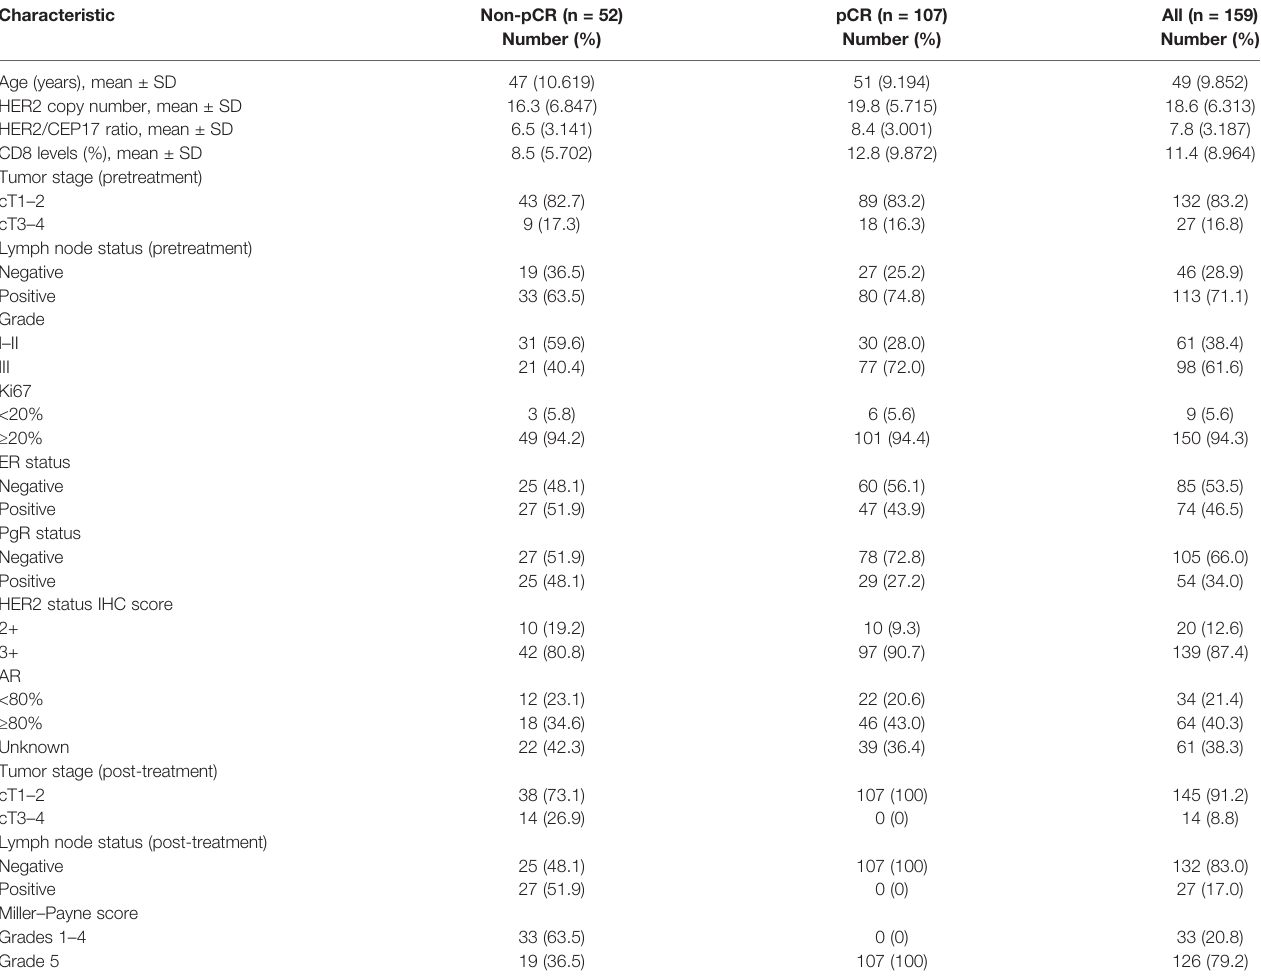
TABLE 1 | Patient characteristics according to pathological complete response.